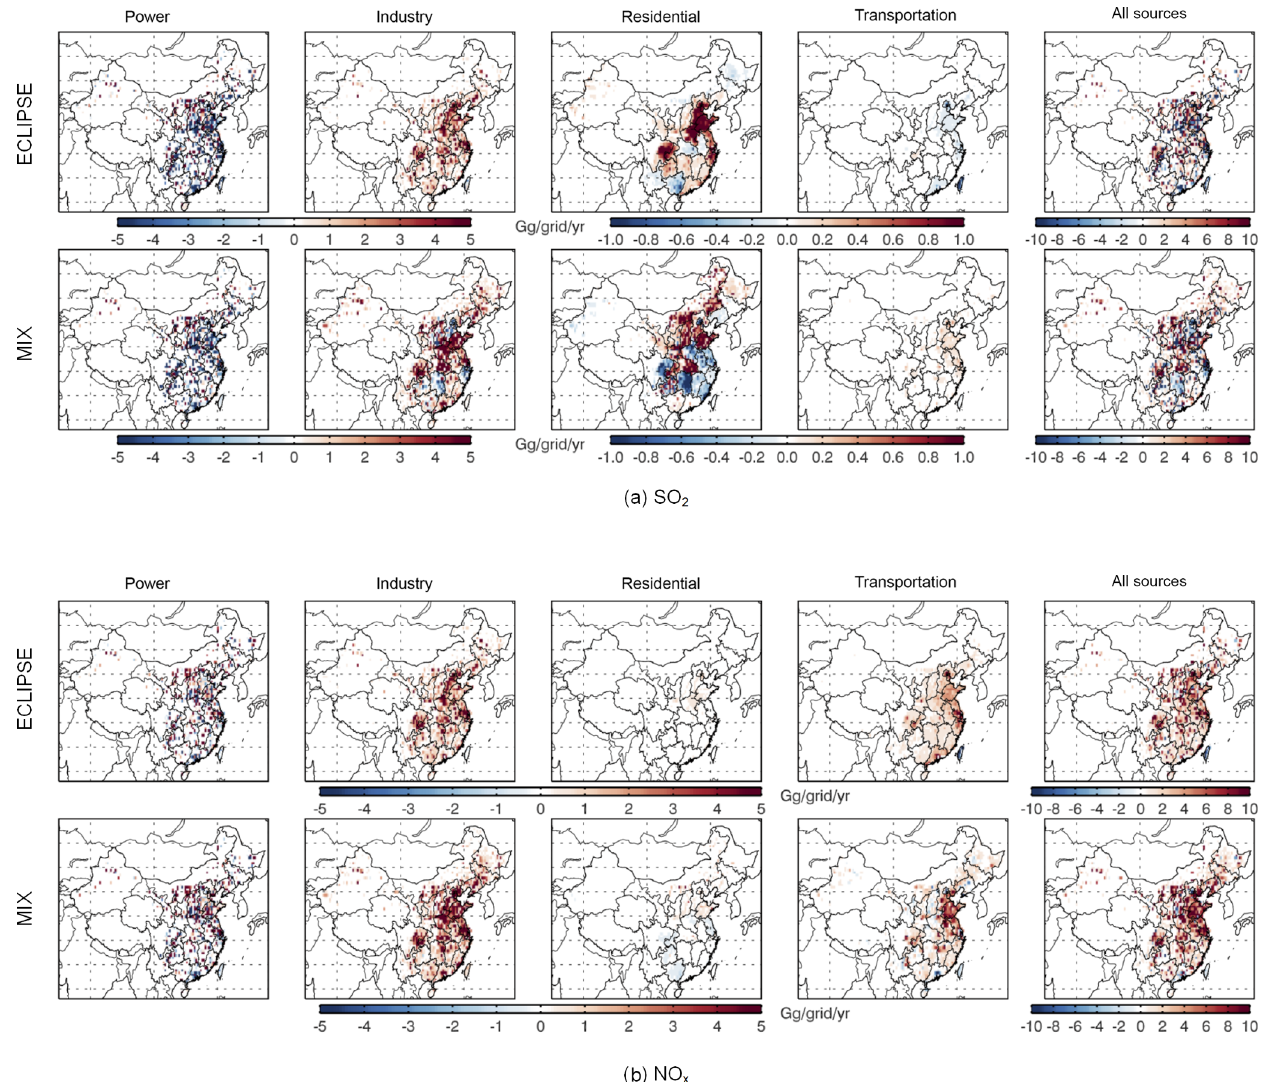
Figure 5. SO 2 (a) and NO x (b) emission changes from 2005 to 2010 by sectors calculated as E 2010 – E 2005 , at 0 . 5 ◦ × 0 . 5 ◦ grids. Note different color scales are used among